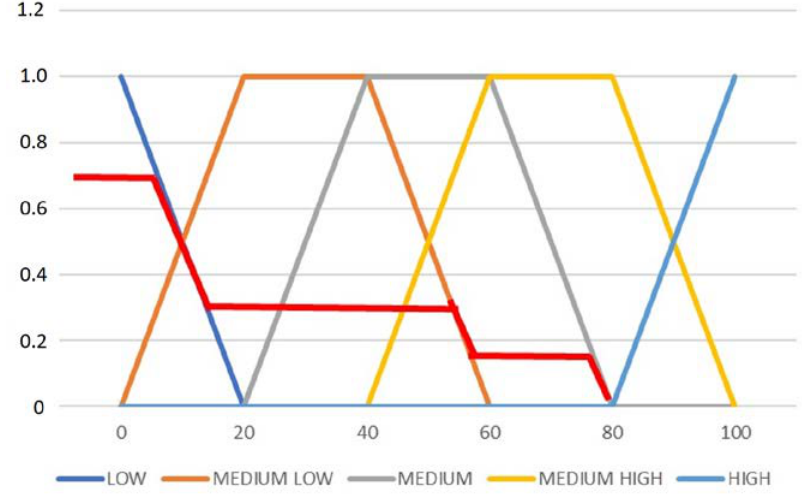
18 Figure 18. Aggregation of rules for design for manufacturing organization